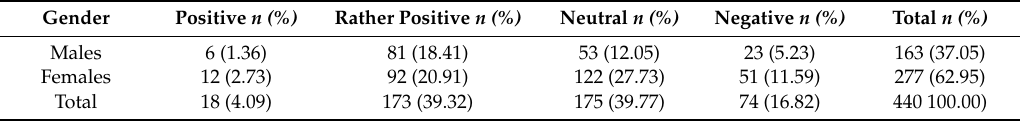
Table 1. Distribution of the population between gender and career prospects.